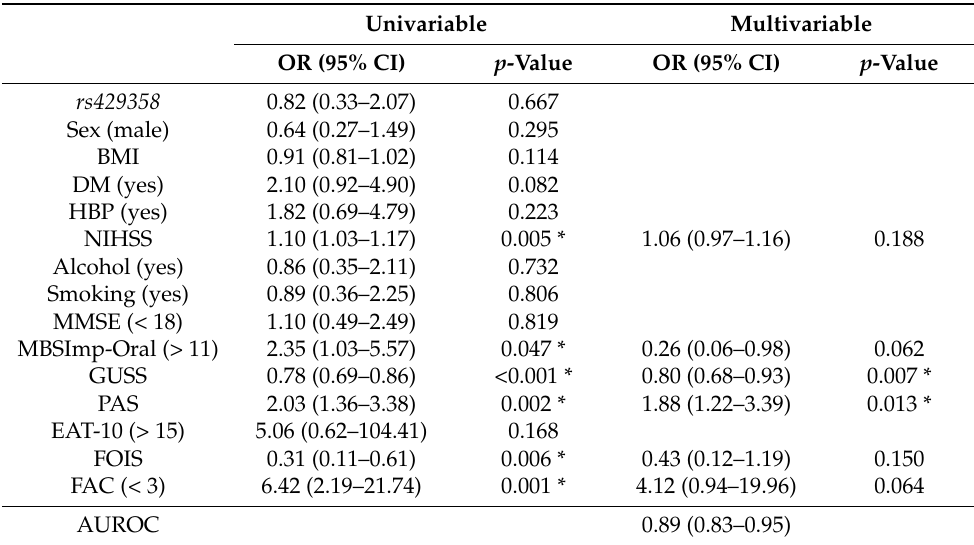
Table 4. Univariable and multivariable analysis in the older age